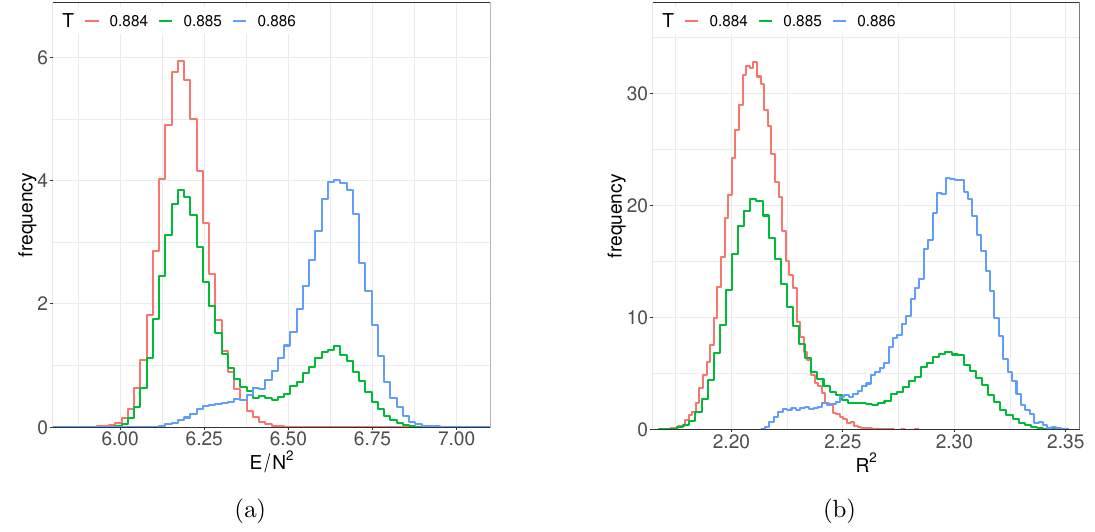
Figure 12. N = 64, L = 24, D = 10: a) binned E for various T . b) binned R 2 for various T